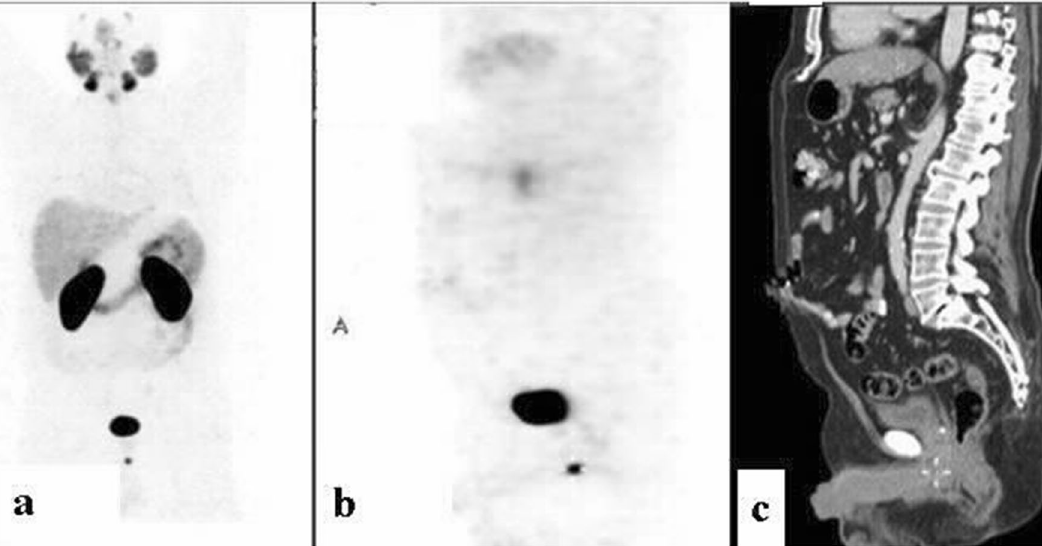
Figure 6. Ga-68 PSMA PET/CT: maximum intensity projection (MIP) ( a ) representative PET ( b ) and CT ( c ) axial slices demonstrating focally increased uptake in lesions at the root of the penis. A 62-year-old man with metastatic adenocarcinoma of the prostate with perineural invasion, who had not undergone prior prostatectomy, with a Gleason’s score of 7 and PSA of 76 (patient #6, Table